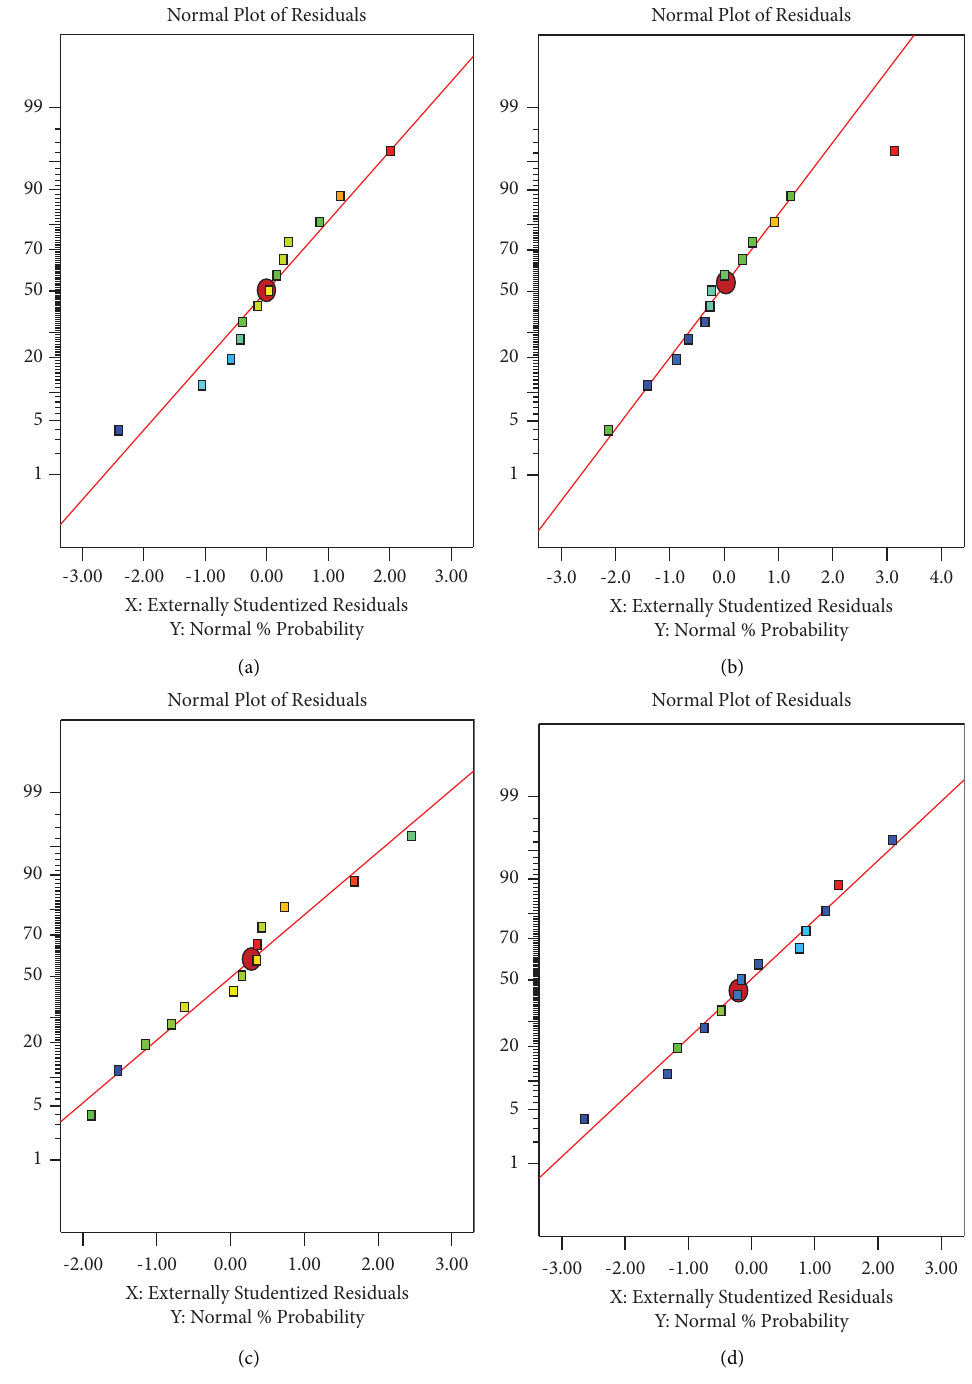
Figure 1: Normal plot response optimization of cellulose components: (a) water-extractive material, (b) hemicellulose, (c) cellulose, and (d)